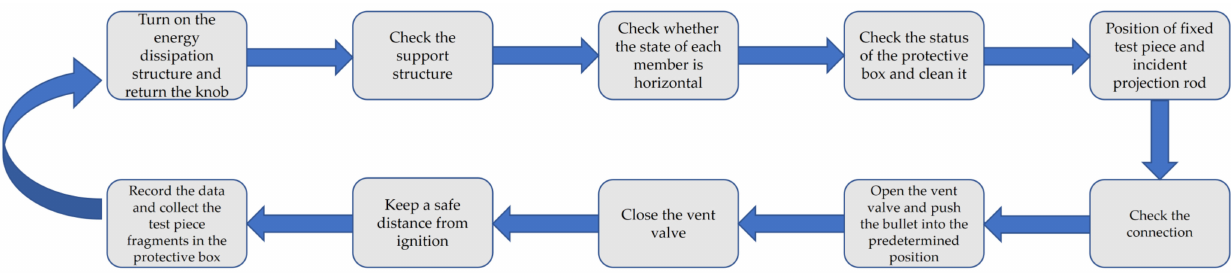
Figure 4. Flow chart of SHPB installation for impact compression